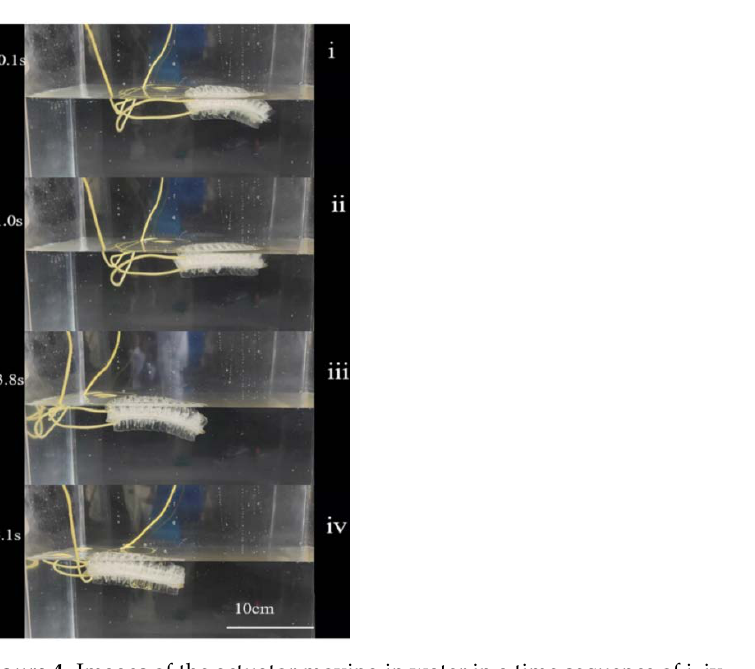
Figure 4. Images of the actuator moving in water in a time sequence of i–iv. Table 1. Comparisons of recently shown underwater soft actuators. The speed is described using body length/second